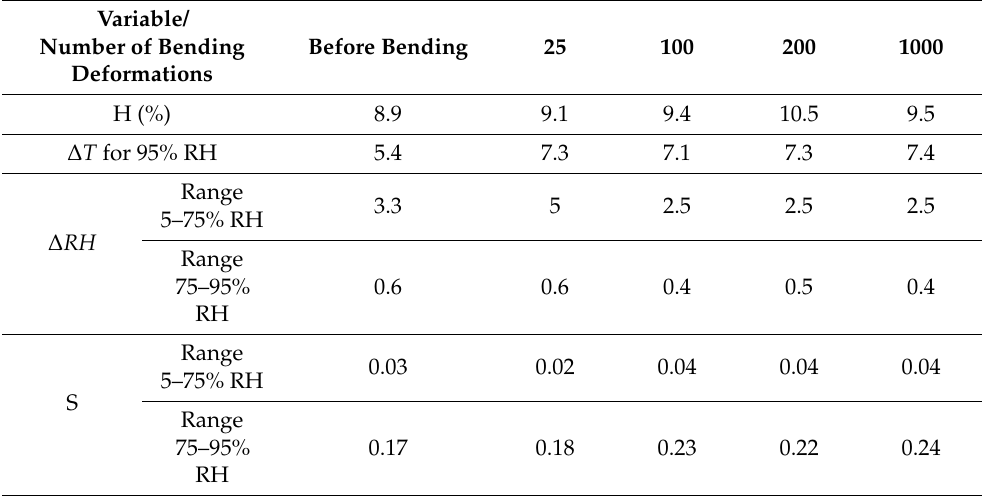
Table 1. Percentage of hysteresis H in %, transmittance changes ∆ T in %, accuracy/resolution ∆ RH in % RH and sensitivity S in %/%